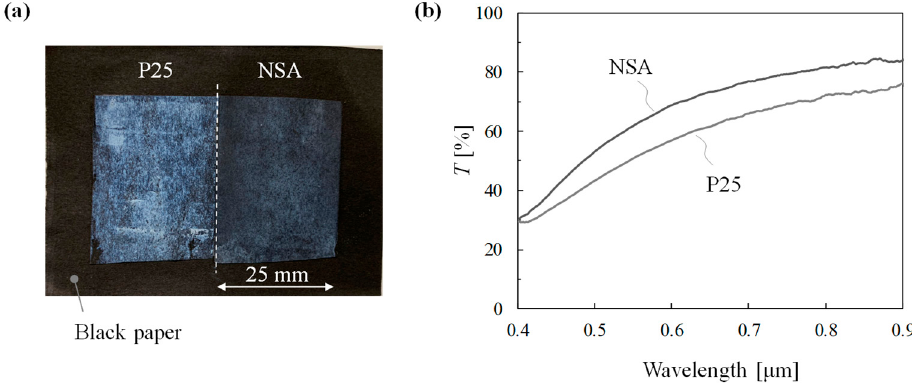
Figure 3. ( a ) Photograph of a coating surface on black paper. ( b ) Spectral transmittance in the visible wavelength range.